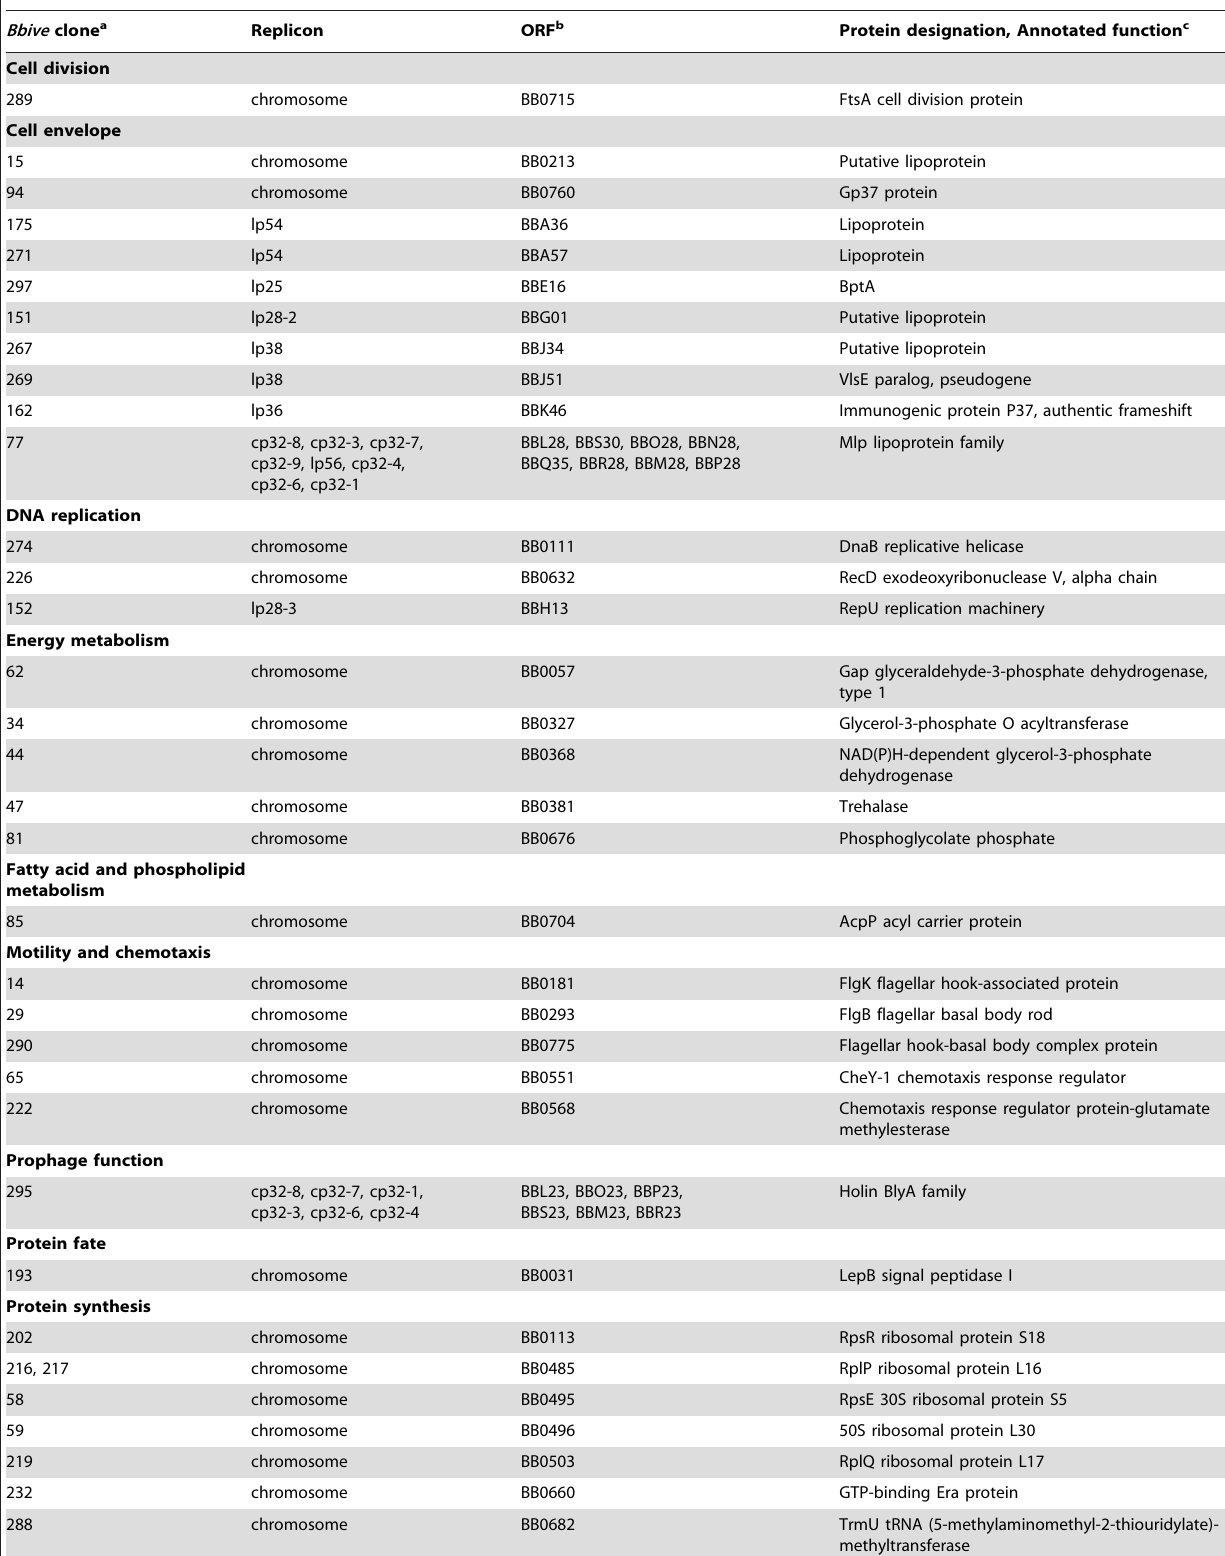
Table 3. B. burgdorferi in vivo -expressed candidate genes organized by functional